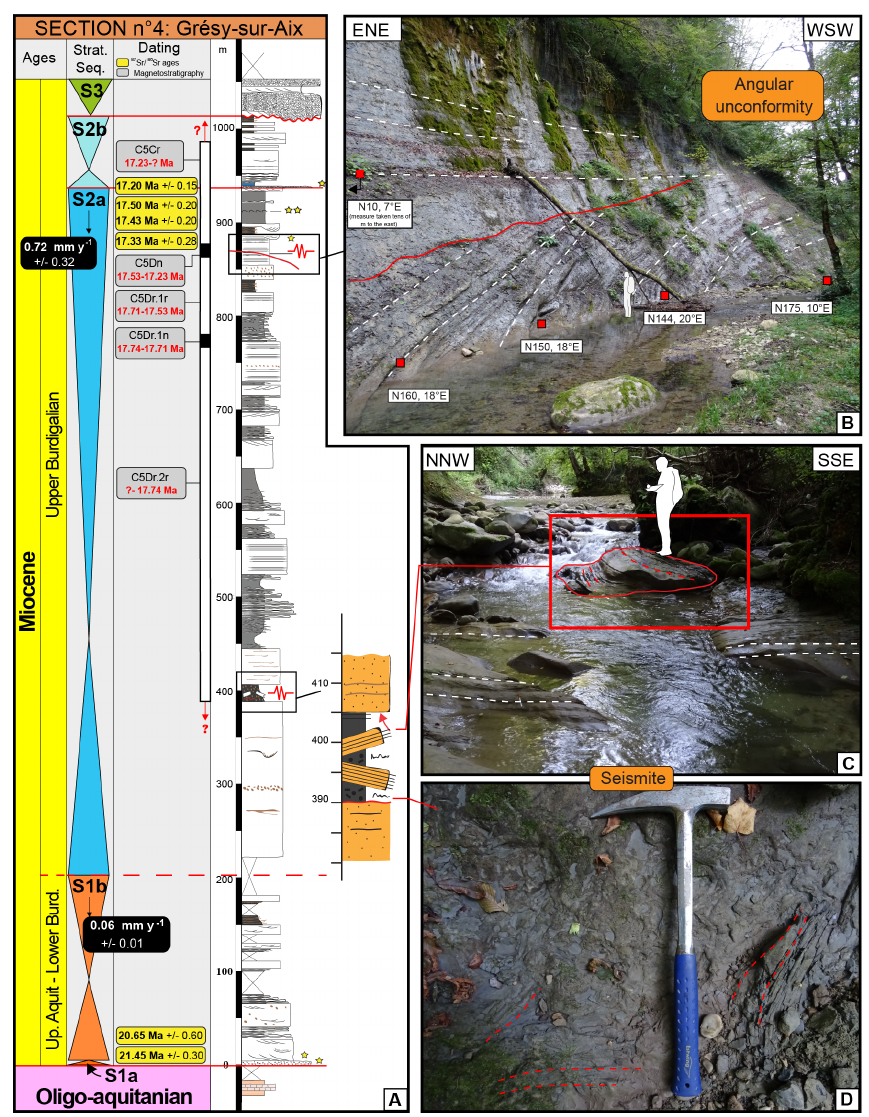
Figure 12. (A) Grésy-sur-Aix sedimentological section with sequence S2a syntectonic deposits indicated: seismite near the bottom (see also C and D ) and angular unconformity near the top (see also B ). The S2a sequence boundary was observed and dated in the Forezan section (5, Fig. 2). Legend in Fig. 5. Black box: average sedimentation rate of the sequence. (B) The angular unconformity has established between 17.53 and 17.23Ma within Chron C5Dn. White dashed lines: bedding. Red line: erosive surface. Red square: dip measure. (C) Seismite disturbing 15m of sediments in S2a, with plurimetric blocks tilted in situ and slump balls. (D) Detail of an intensively disturbed sedimentary